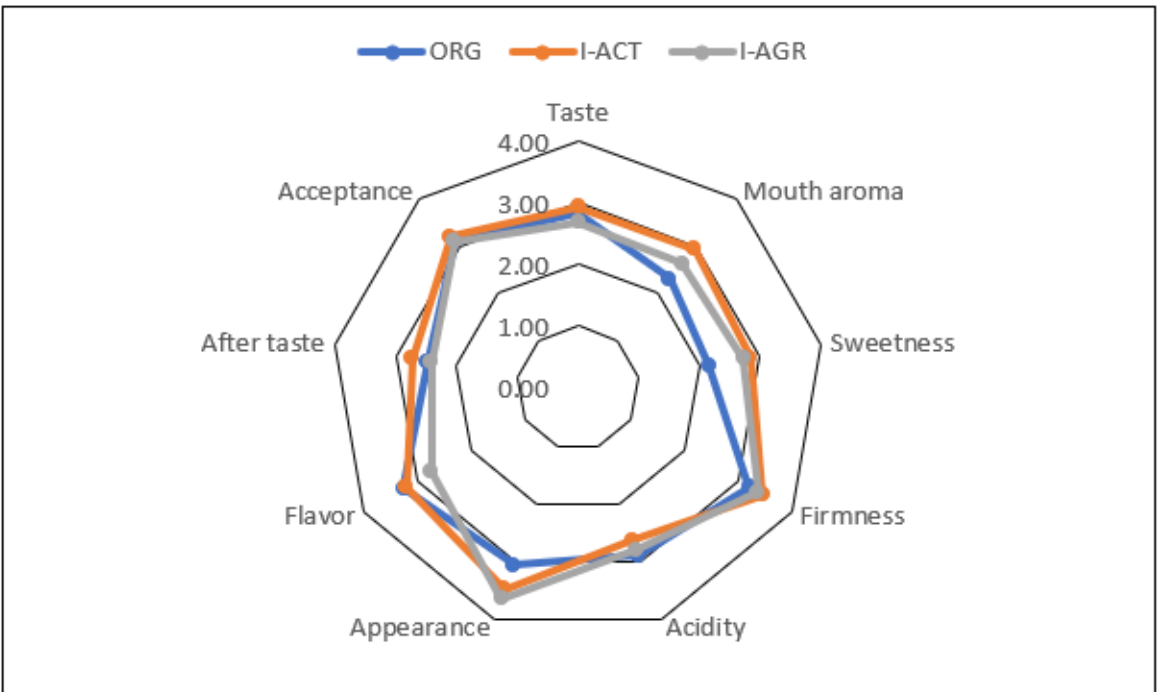
Figure 1. Spider chart of the results of the taste panel based on the taste and perception attributes tested. ORG, organic; I-AGR, integrated based on Agrobiosol amendment; I-ACT, integrated based on Activit amendment.